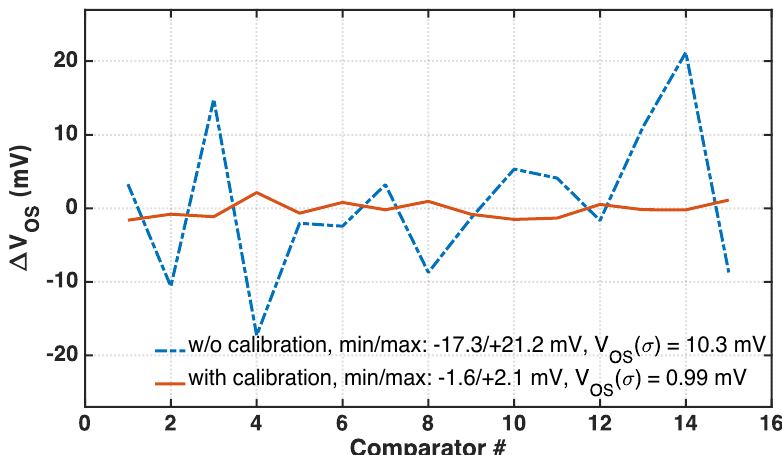
Figure 10. Measured raw and calibrated comparator offset voltage with the proposed calibration at 11GHz.